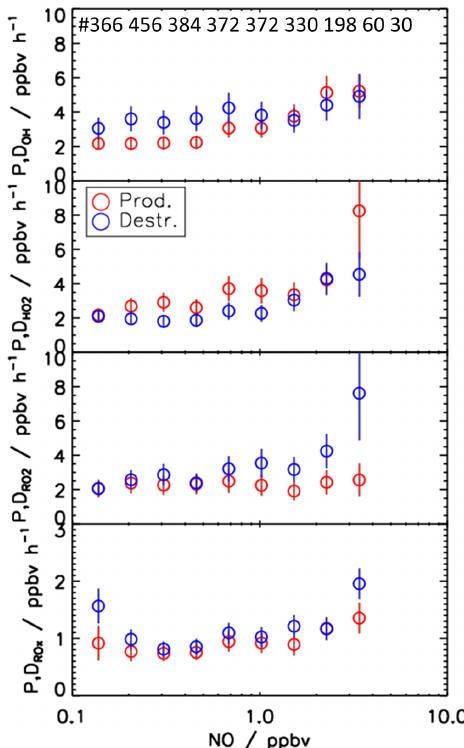
Figure 12. NO dependence of median production and destruction rates of OH, HO 2 , RO 2 , and RO X radicals. Median values include all data from the spring and summer periods of the JULIAC cam- paign (NO intervals: ln(NO) = 0.4ppbv). Vertical bars represent the 1 σ uncertainty from experimental errors of the measured quantities (Table 2) and of the reaction rate constants (Table 1). The number of data points in each NO bin is represented on the top